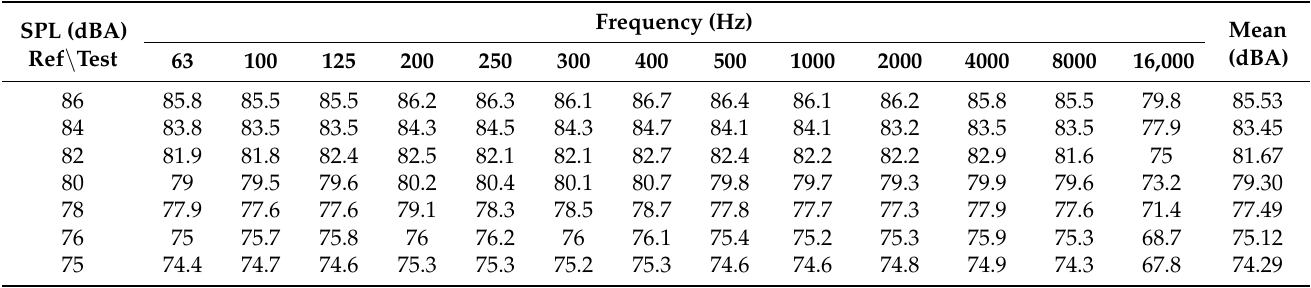
Table 1. The detailed data of SPL accuracy experiment. The first column is the reference SPL, and the data in the middle area show our measured SPL at artificial ear left side. Since our test was conducted in an open environment, not acoustic laboratory, there is measurement error at a single frequency point, but the mean is close to the reference SPL.